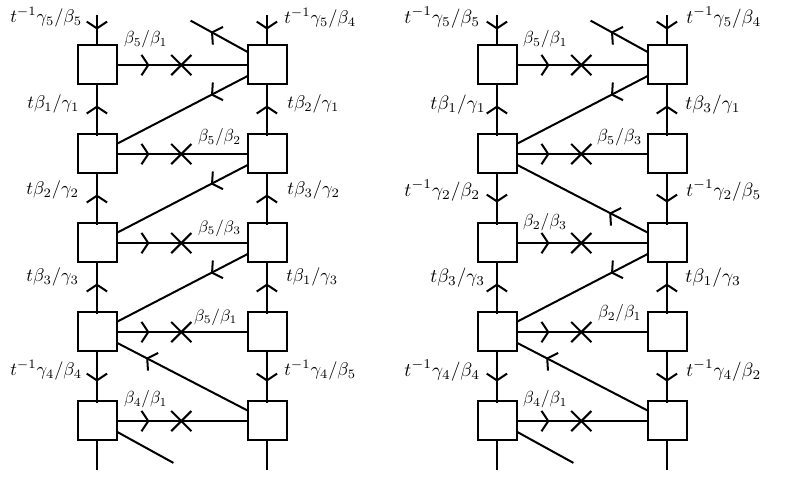
Figure 3 . Domain walls for B = f + ; + ; + ; (cid:0) ; (cid:0)g (left) and B = f + ; (cid:0) ; + ; (cid:0) ; (cid:0)g (right). The U(1) global charges of the 4d chiral (cid:12)elds denoted by their fugacities are (cid:12)xed by the gauge-global mixed anomaly cancellation and superpotential terms. Here the permutation (cid:27) (cid:12) = (1 2 3)( 4 5) and (cid:27) (cid:13) = ; for the left tube. For the right tube (cid:27) (cid:12) = ( 1 3 )(2 5 4 ) amd (cid:27) (cid:13) = ;